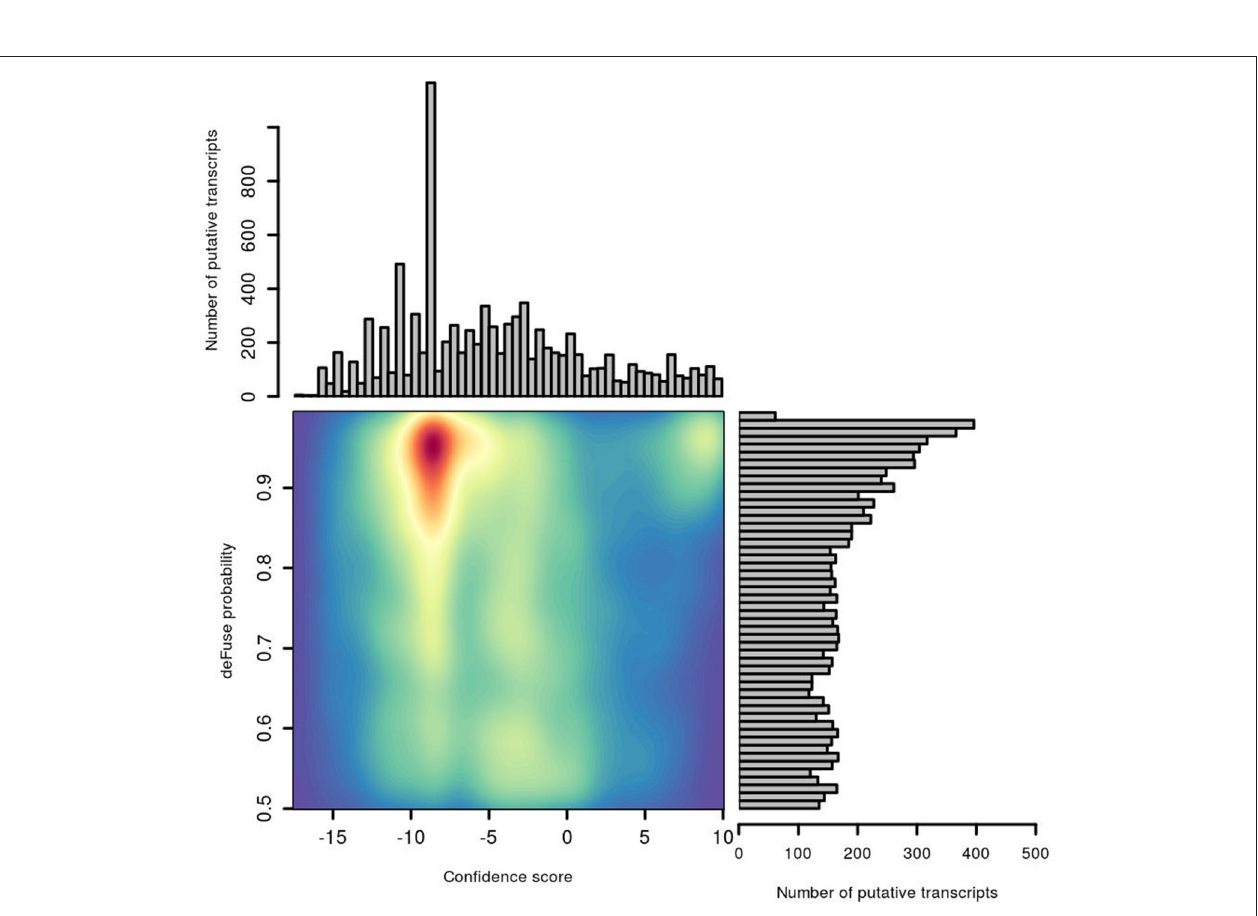
FIGURE 6 | Comparison of probability predicted by deFuse and confidence score by confFuse in 96 published RNA-seq samples. High density is of red color and low density is of blue color.